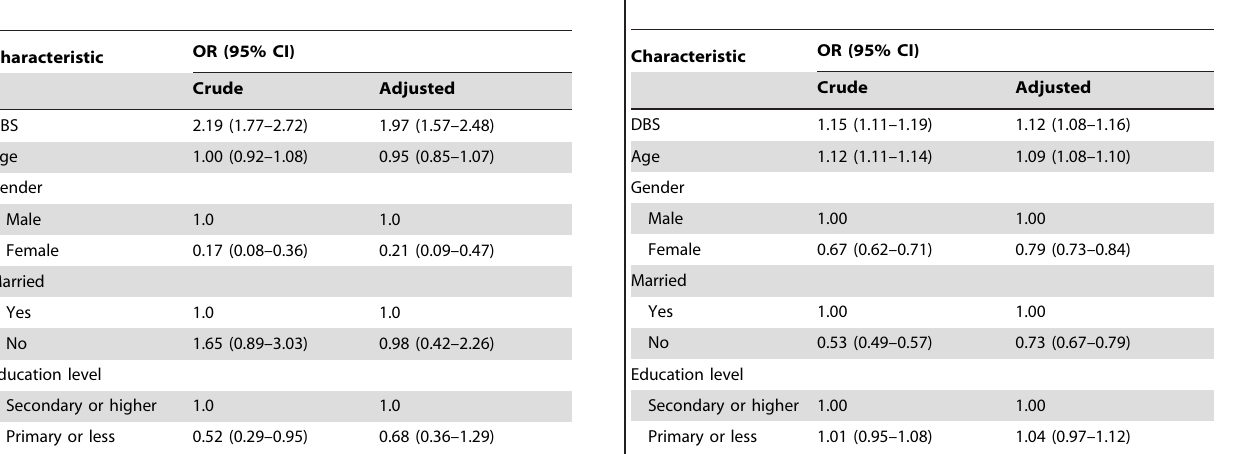
Table 3. Logistic regression analyses of the relationship between the DBS and multiple sexual partners.